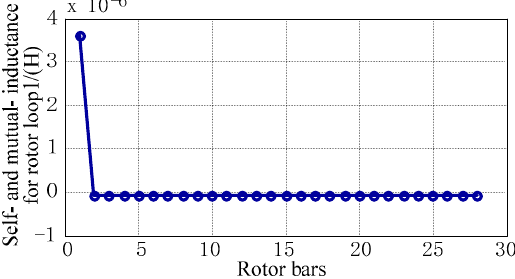
Figure 6. Inductances of the rotor loop 1.